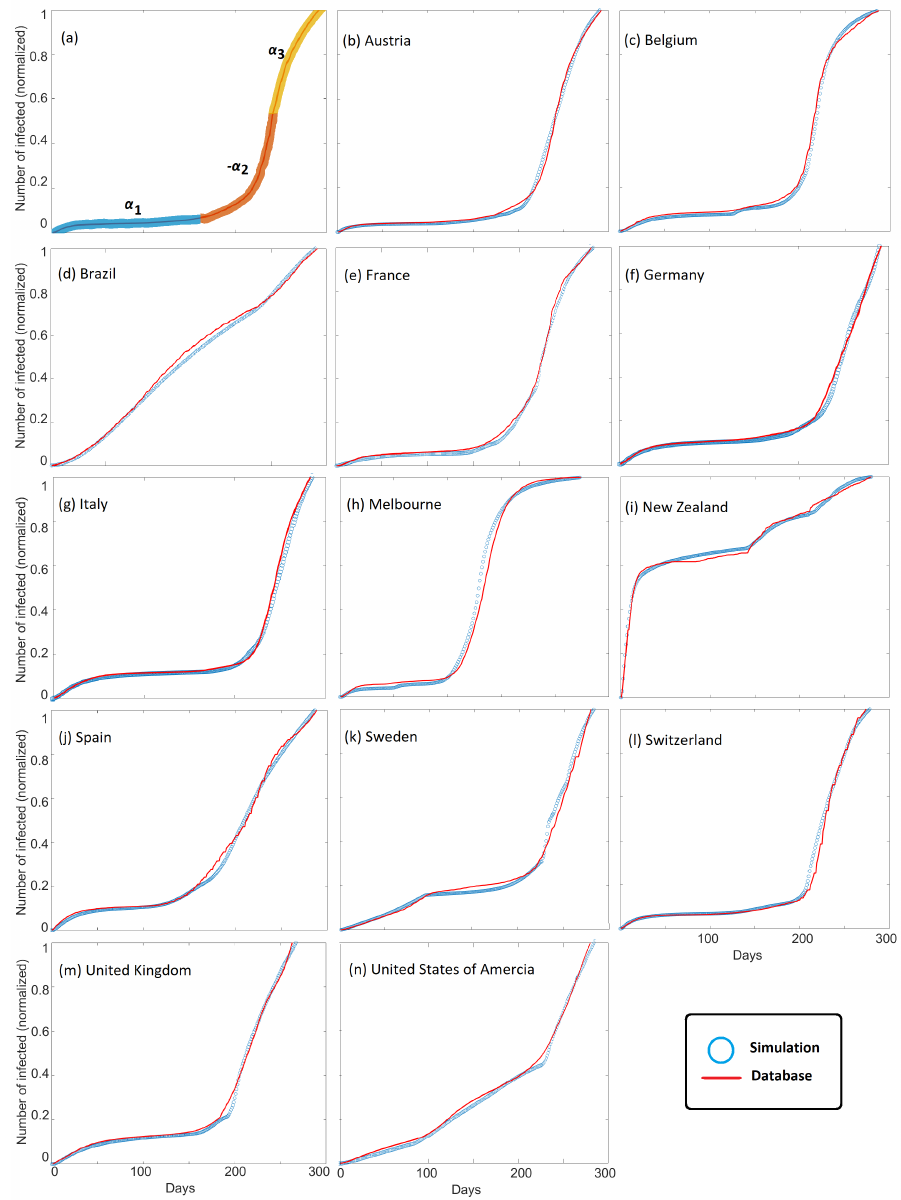
Figure 3. Comparison of all data (red) in Figure 1 superposed with the corresponding model results (blue). The data constrains ± α = ± ζ and how this is achieved is demonstrated in ( a ). The colors in ( a ) represent the duration of each phase. Excellent agreement in all cases is